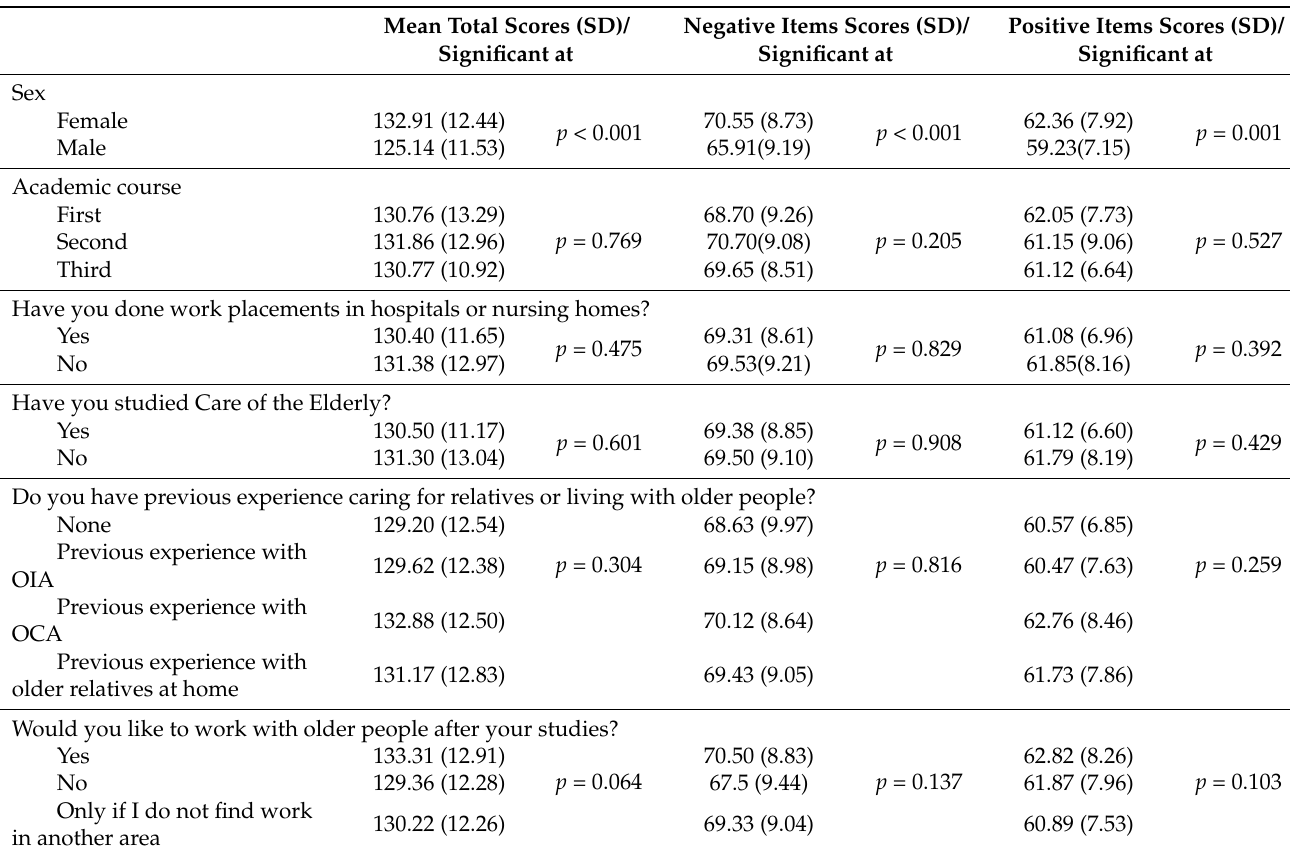
Table 2. Mean and SD of Kogan’s scores according to different variables.